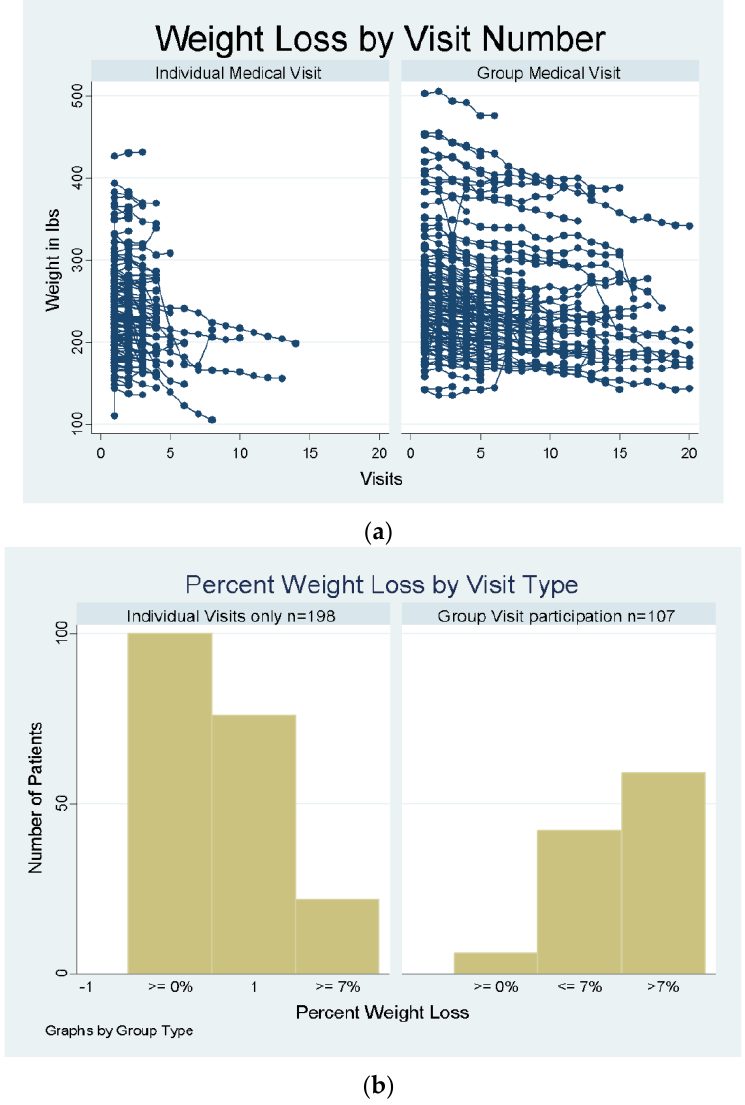
Figure 1. ( a ) Weight by Number of Visits in Each Group. ( b ) Percent Weight Loss by Visit Type. Data for blood pressure were available from 81 patients. There were 22 subjects in the IMV and 59 subjects in the GMV. As shown in Figure 2a, the mean baseline systolic blood pressure for GMV and IMV were 138.7 mmHG, and 124.41 mmHg, respectively. The mean baseline diastolic blood pressure for GMV and IMV were 77.9 mmHg and 67.6 mmHG, respectively. The difference between baseline and three months systolic blood pressure in the GMV and IMV was − 7.4 vs. 4.1 mm of Hg ( p = 0.002), respectively. The difference for diastolic blood pressure between GMV and IMV, for baseline and three months, was − 4.6 vs. 4.2 mm of Hg ( p = 0.003), as shown in Figure 2d. Individuals were classified as either less than or greater than 5% weight loss. This level, 5% weight loss, is related to a reduction in metabolic markers such as blood pressure [24]. Those who lost >5% of their baseline weight had a higher reduction in overall blood pressure, as shown in Figure 2a. For systolic blood pressure, the difference between baseline and three months was − 9.8 vs. 0.73 mm of Hg for subjects losing >5% weight comp ared to those losing ≤5% weight. For diastolic blood pressure, the difference between baseline and three months was −6.6 vs. 1.81 mm of Hg for subjects losing >5% weight compared to those losing ≤5% weight. Figure 2.